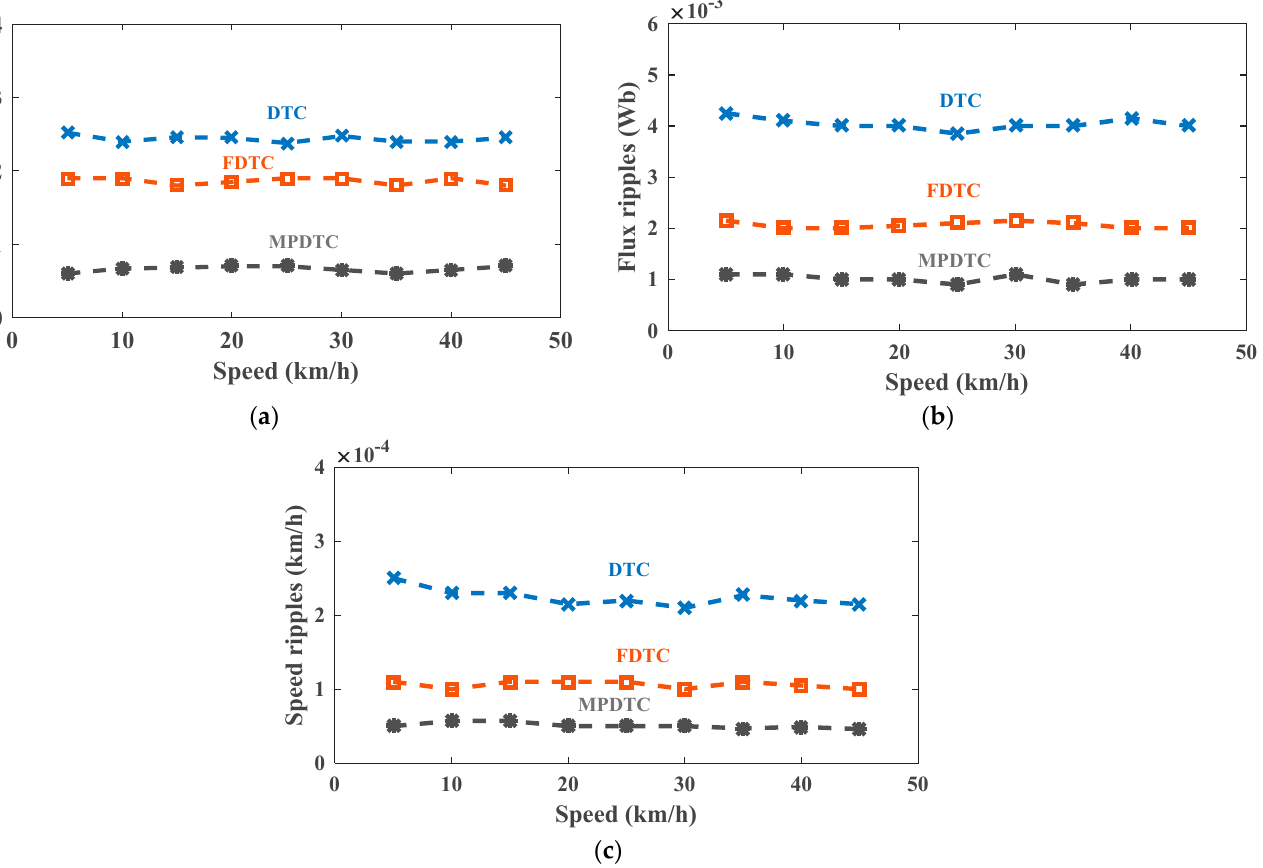
Figure 17. Stator fl ux loci of the PMSM under di ff erent control techniques with NYCC driving cycle.